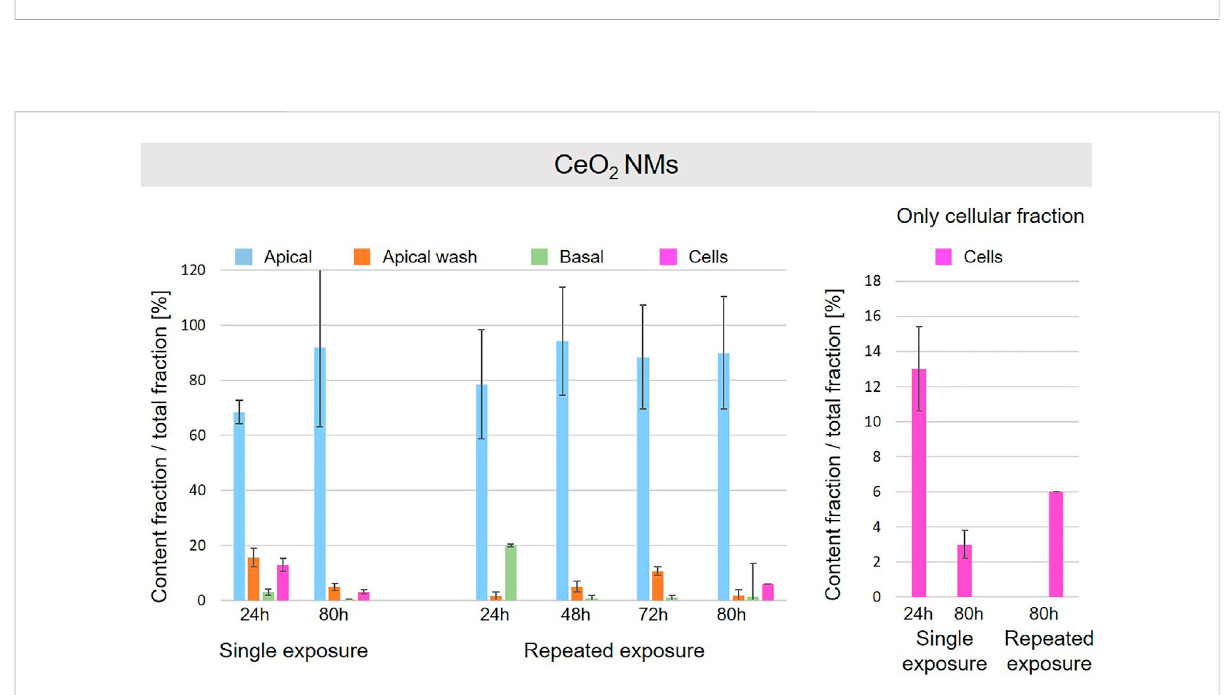
FIGURE 6 Fate of CeO 2 NMs at the A549 tissue barrier after single and repeated exposures. For single exposures CeO 2 NMs was exposed at a concentration of 100 µg/ml and the different fractions were collected after incubation for 24 and 80 h. For repeated exposures the cells were exposed repeatedly every day up to 80 h, using 25 µg/ml CeO 2 NMs concentration, resulting in a total exposure of 100 µg/ml and 80 h incubation time intotal. Apical, apical cellwashandbasal sampleswerecollectedafter 24, 48, 72,and 80 hofexposure.Right side: This graph onlydepicts the cellular fraction. A total of three independent experiments ( n = 3), with three single replicates each, were